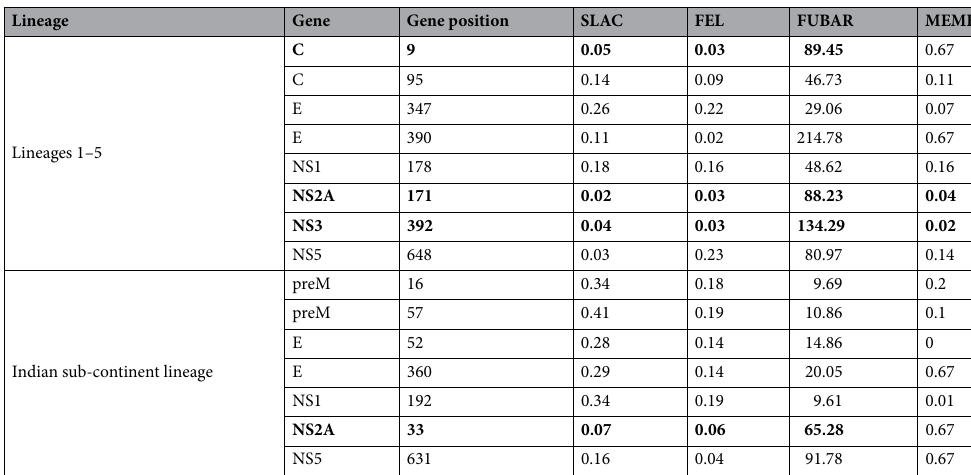
Table 3. Selection pressure analysis of the complete coding region of cosmopolitan genotype. Positive selection was evident on residues in bold font, based on the selection pressure analyses. The values shown for each method are p-values, except for the FUBAR method for which the values indicate the Bayes factor. The p-values ≤ 0.1 were considered as significant for SLAC, FEL, and MEME methods, whereas the Bayes factor ≥ 30 was used for FUBAR method. C Capsid, E envelope, NS non-structural proteins.